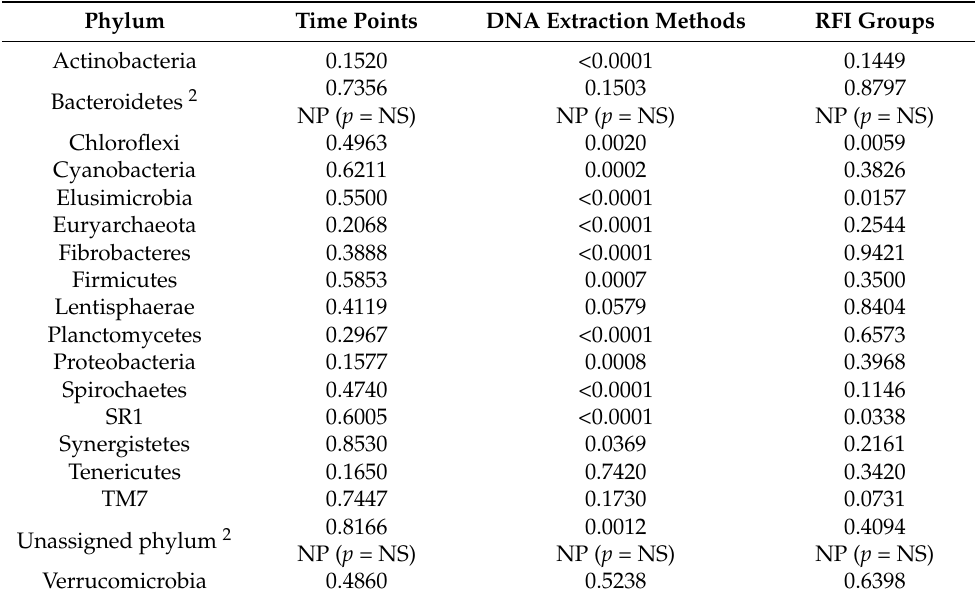
Table 3. Summary of statistical results ( p -values) at the phylum level 1